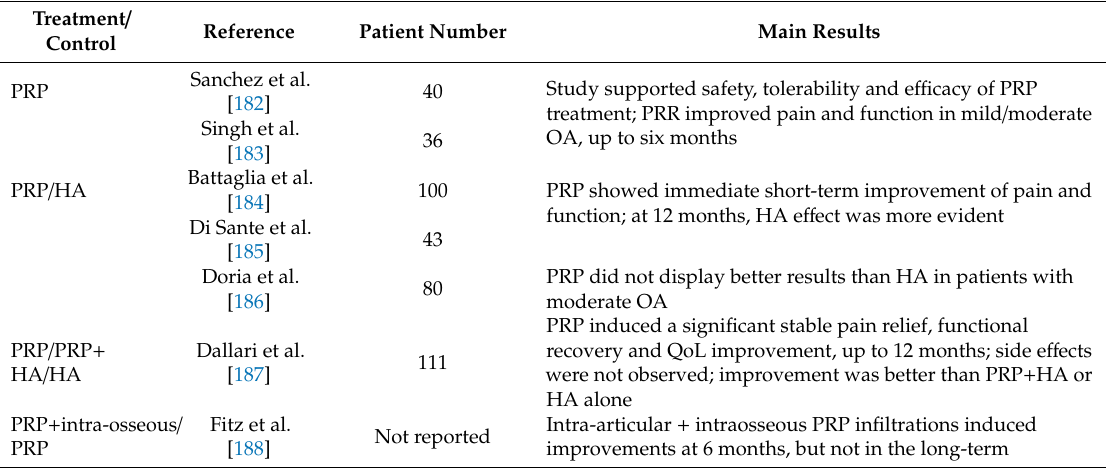
Table 4. Evidence of PRP treatment in hip osteoarthritis (reported by year of study and grouped by